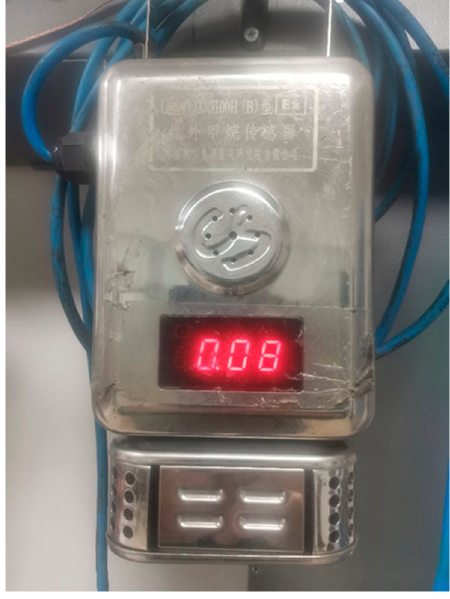
Figure 1. Methane transducer.